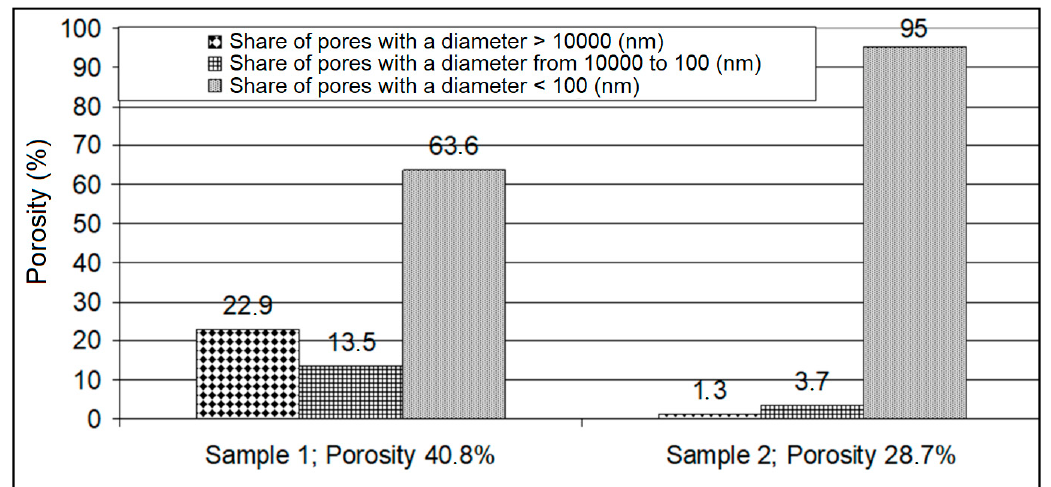
Figure 13. Porosity coefficient values and shares of individual pores for samples 1 and 2.